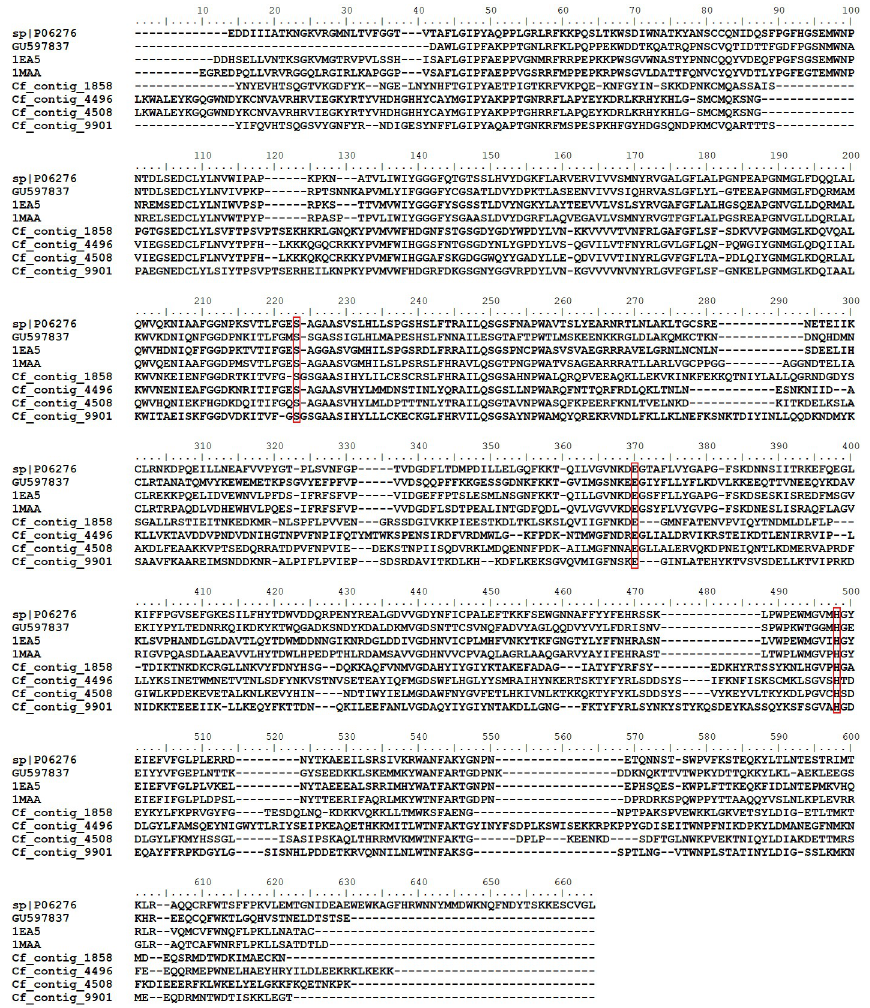
Fig 2. Amino acid alignment acid phosphatases. Human prostatic acid phosphatase (NP_001090.2) and acid phosphatases from X . cheopis (ABM55413.1, ABM55400.1, ABM55403.1, ABM55410.1, ABM55411.1, ABM55409.1) previously identified by mass spectrometry analysis in the flea salivary glands and C . felis acid phosphatases. The motifs containing the histidine residues relevant for the hydrolysis of phosphate monoesters are boxed in